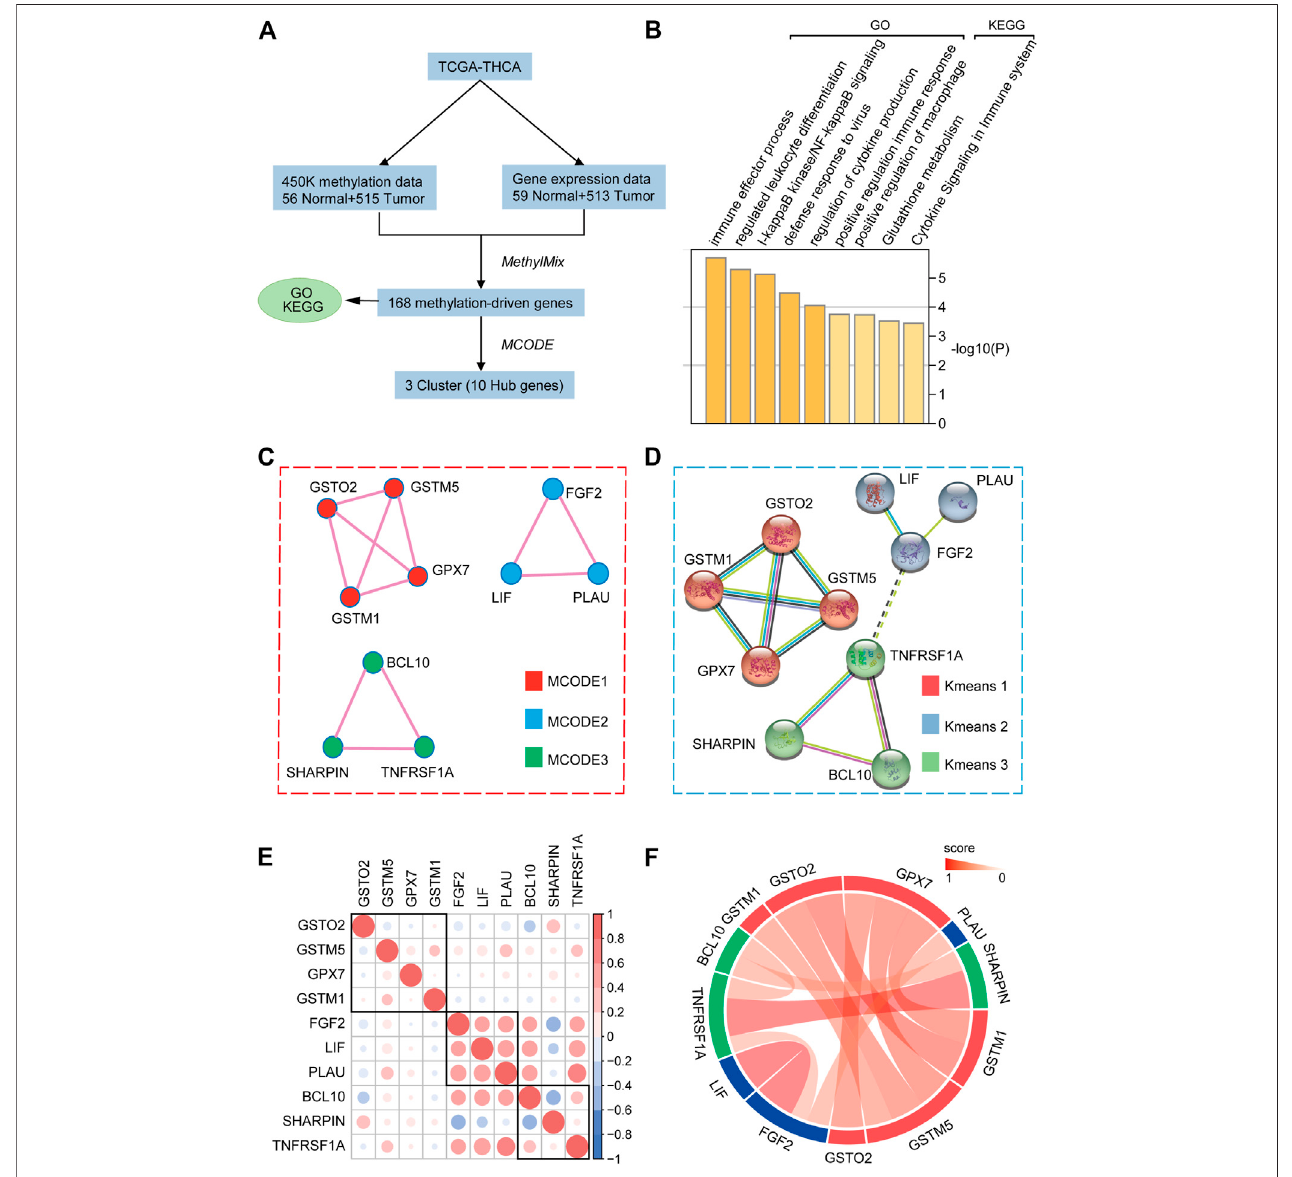
FIGURE1| Selectionofhubmethylation-drivengenes. (A) Schematicwork fl owforthescreeningofmethylation-drivengenesinTHCA. (B) GOandKEGGpathway analysesof168indicatedmethylation-drivengenes. (C) MCODEalgorithmidentifyingthemajormodulesof168methylation-drivengenes. (D) Protein-proteininteraction network and K-means clustering model of hub genes. (E) Hub gene correlation at the transcriptional level. (F) Hub genes ’ linkage score at the protein level.